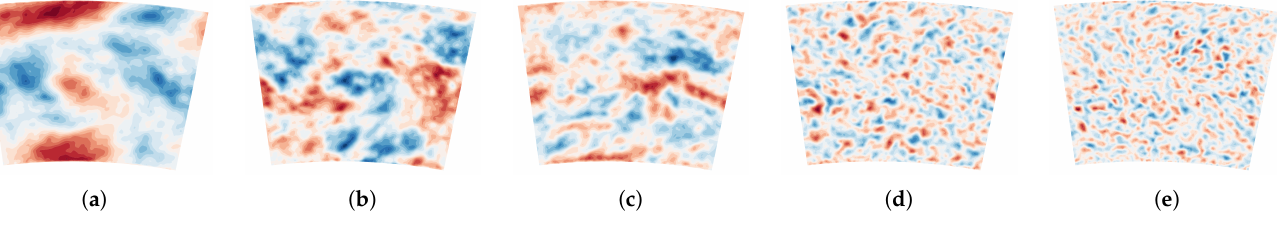
Figure 8. First mode for axial velocity. ( a ) 500 Hz. ( b ) 1000 Hz. ( c ) 1500 Hz. ( d ) 5000 Hz. ( e ) 8000